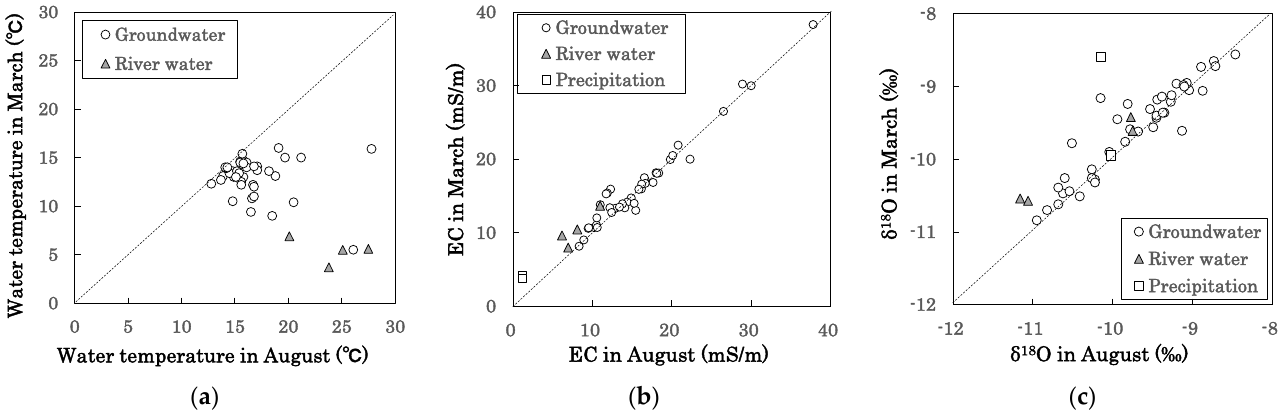
Figure 4. ( a ) Temperature, ( b ) EC, and ( c ) δ 18 O difference for groundwater and river water between August and March. The broken lines indicate constant values throughout a year at each sampling site.